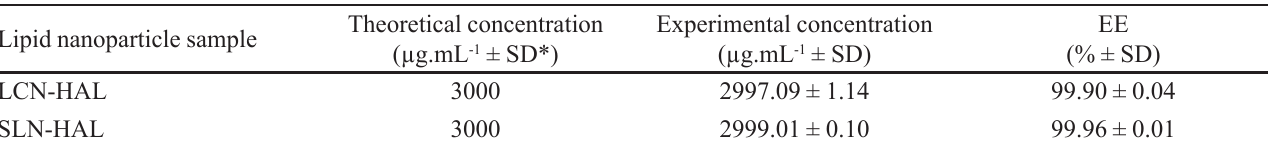
TABLE VI - Halcinonide-loaded and encapsulation efficiency (EE) for polymeric lipid-core nanoparticles (LCN) and solid lipid nanoparticles (SLN) Lipid nanoparticle sample